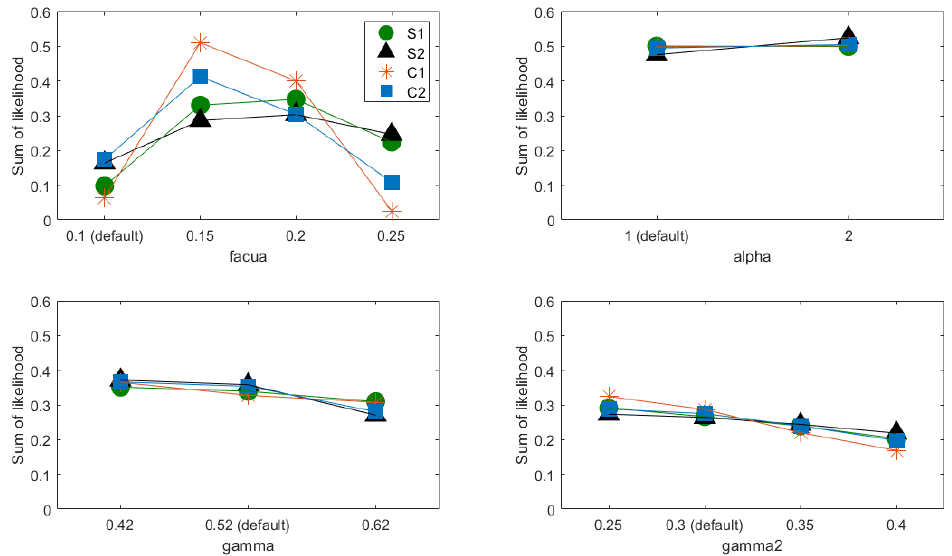
Figure 10. Sum of the likelihood at given ranges of each key parameter ( facua , alpha , gamma , and gamma2 ). The higher sum of likelihood indicates that higher BSS values are distributed at the parameter value. In addition, a large variance of the sum of likelihood distribution indicates a high model sensitivity within given parameter combinations and incident wave conditions.